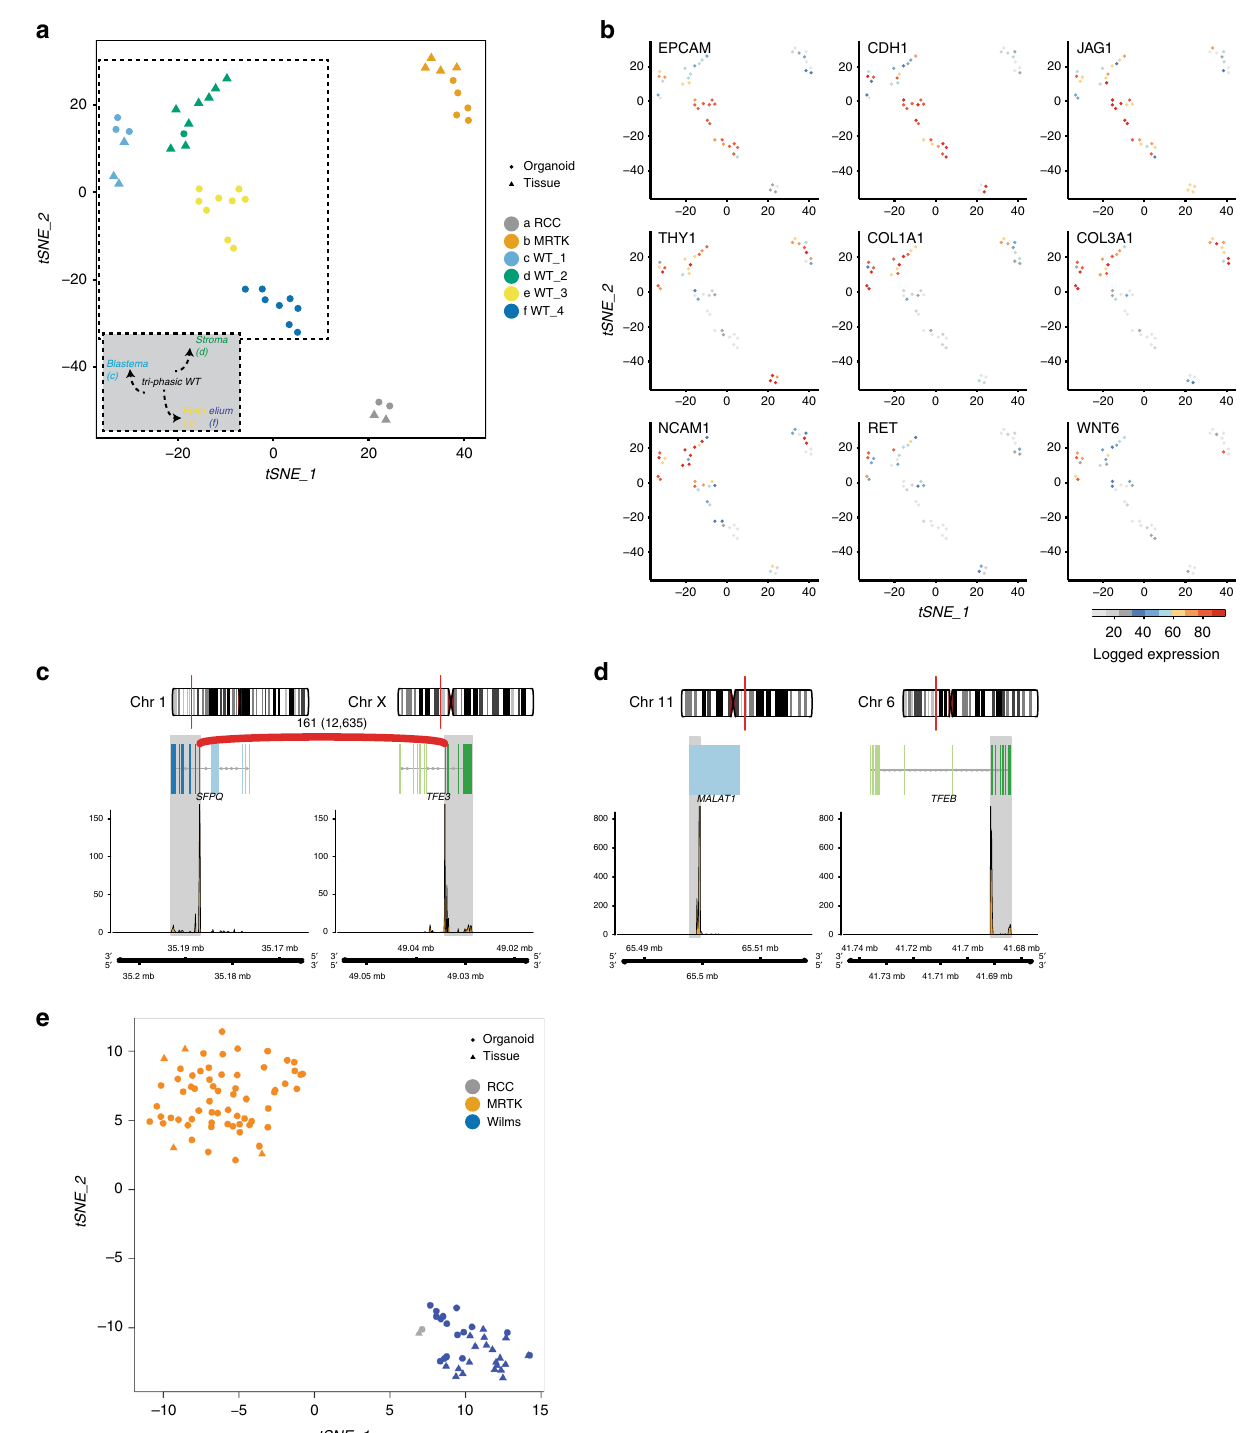
Fig. 5 Transcriptome and DNA methylation pro fi ling of paediatric kidney cancer organoids. a t-SNE representation of unsupervised graph-based clustering of paediatric kidney cancer organoids and tissues gene expression pro fi les, demonstrating a disease-based separation for the three main tumour types (RCC, MRTK and Wilms tumour) and a composition-based separation for the most prevalent one, Wilms tumour. b t-SNE maps, as in a , showing the colour-coded logged expression levels of several markers used in the clinic or separating the different populations. c , d Depicted are fusion transcripts detected in tRCC-derived organoids 107T ( c ) and 71T ( d ) with their chromosomal location and exon structure and a schematic representation of the fusion breakpoint. Coverage track of the fusion genes is included at the bottom, indicating RNA expression levels. The number above the red arc represents the sequencing reads that support the fusion event. e t-SNE analysis was performed using the top 2000 most variably methylated CpG sites in paediatric kidney cancer organoids and tissues, and revealed that organoids cluster with the tumour entity they were derived